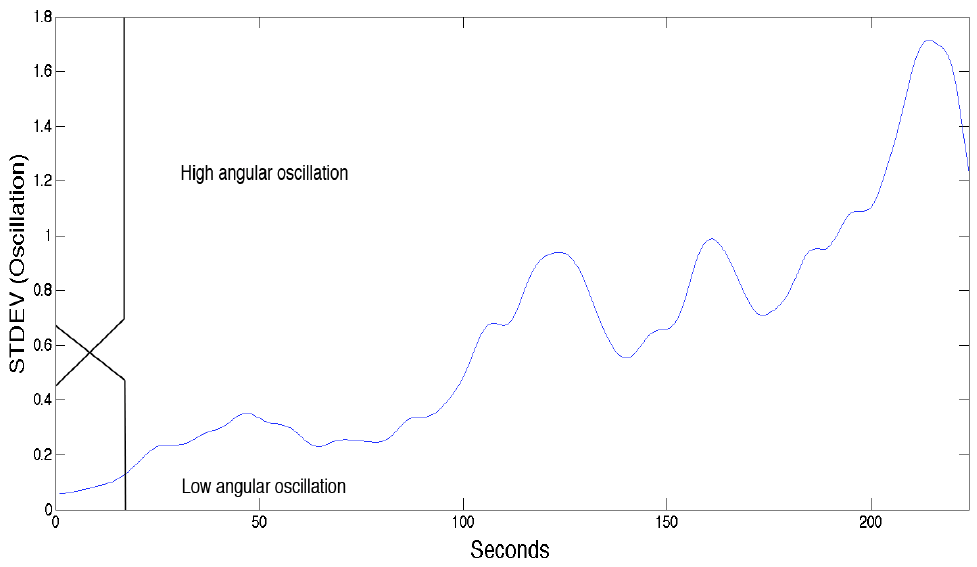
Figure 2. The fuzzy set input for the angular oscillation.